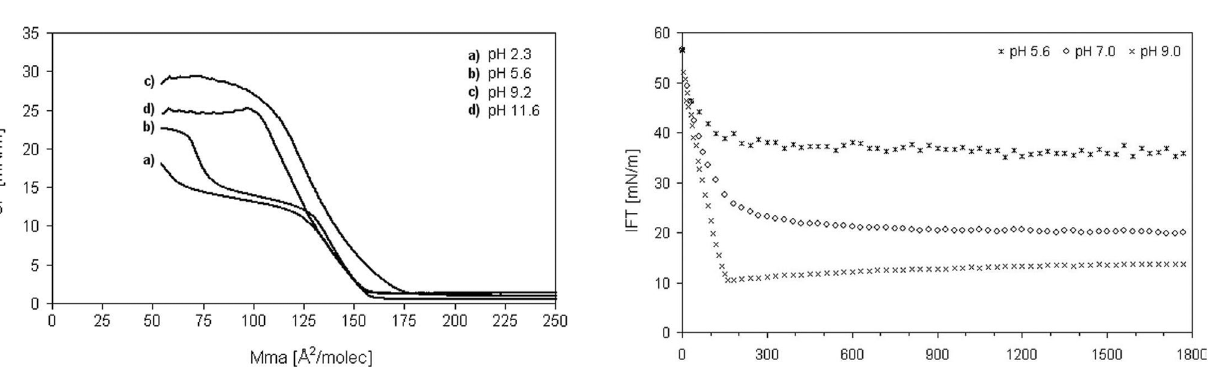
Fig. 3 Surface pressure–area isotherm of tetraacid at different pHs (Brandal et al. 2006)